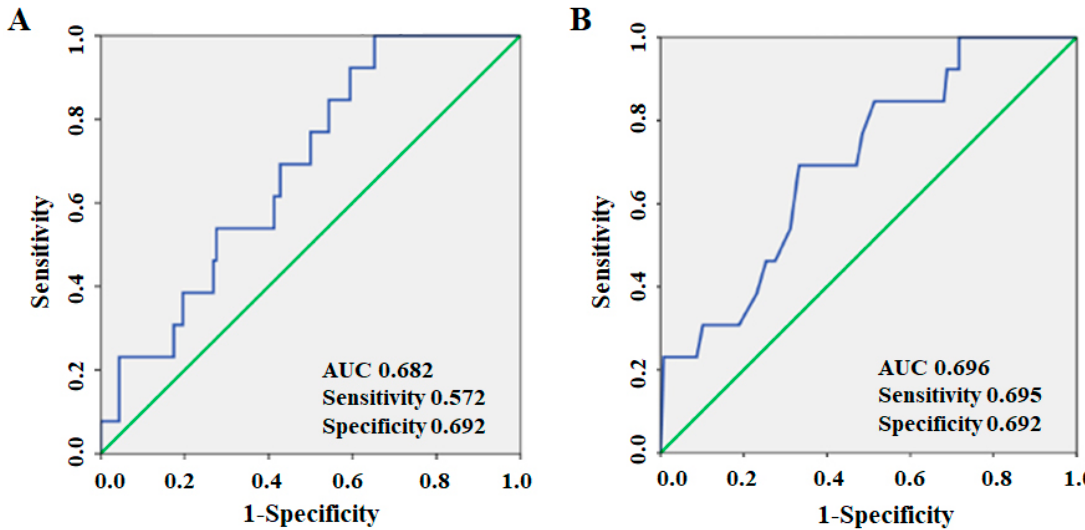
Figure 4. Cut-off values of ( A ) total CEC or ( B ) HDL-C levels for the diagnosis of MACE in all